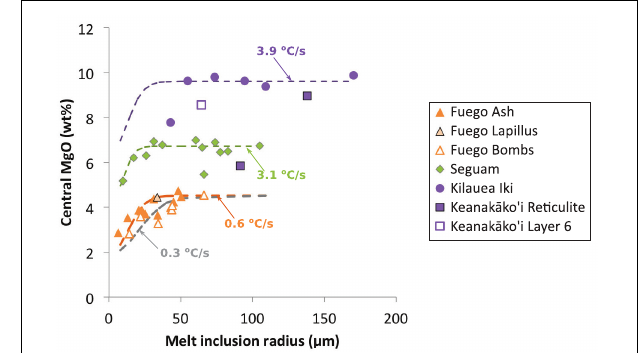
FIGURE 2 | Mg# [molar Mg/(Mg + Fe 2 + )] of melt inclusions against forsterite content of their host olivine crystals. Fe 3 + /(Fe 3 + + Fe 2 + ) in the melt is assumed to be 0.2 at Fuego (Lloyd et al., 2013), 0.23 at Seguam (Zimmer et al., 2010), and 0.18 at Kilauea (Helz et al., 2017). The colored curves indicate equilibrium between olivine and melt, assuming the composition-dependent model for K D proposed by Toplis (2005) (Fuego in green, Seguam in orange, and Kilauea in purple). Note that all Kilauea melt inclusions and the majority of Fuego melt inclusions have undergone some amount of post-entrapment crystallization of olivine (i.e., their measured compositions lie below the equilibrium curve), while several of the Seguam inclusions appear to have undergone post-entrapment melting (i.e., their compositions are too Mg-rich to be in equilibrium with their olivine hosts).